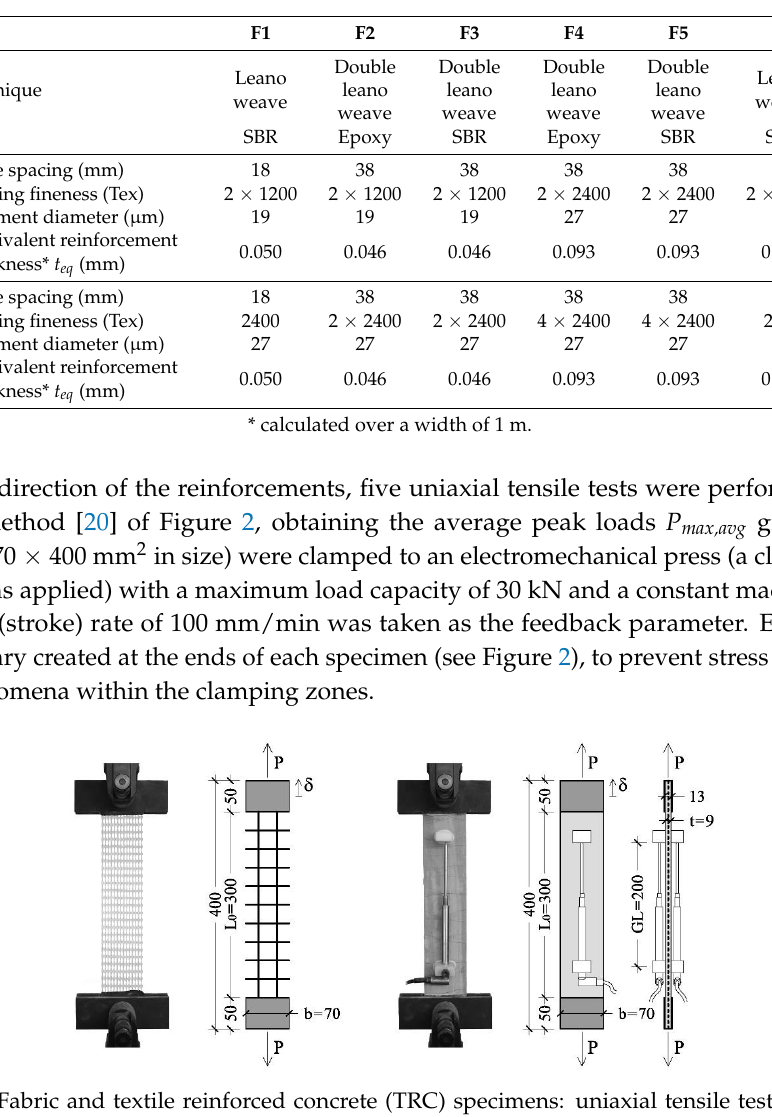
Table 4. Alkali-resistant glass fabrics characteristics.